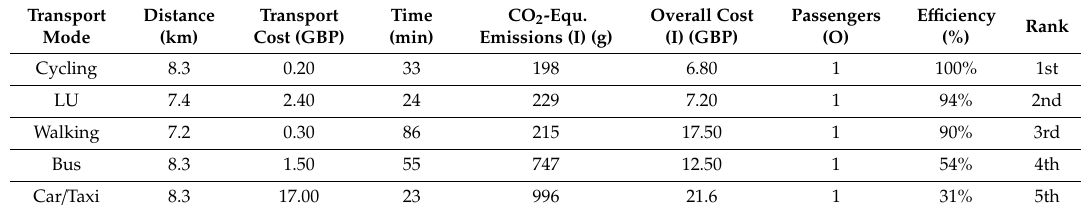
Table 6. Route C. Results in descending order of e ffi ciency of the transport modes DEA model.